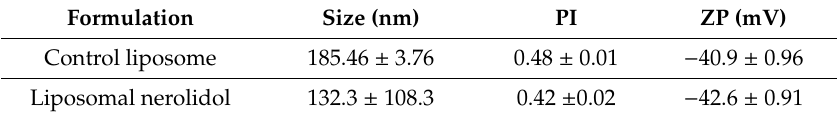
Table 3. Vesicular size (VS), polydispersity index (PI), and zeta potential (ZP) of liposomes.